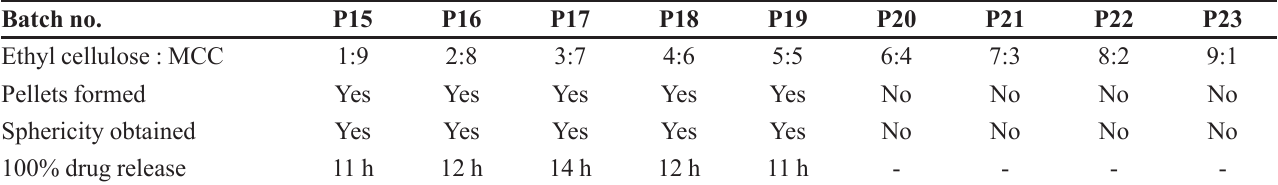
TABLE IV - Evaluation of the methotrexate core pellets Batch no.